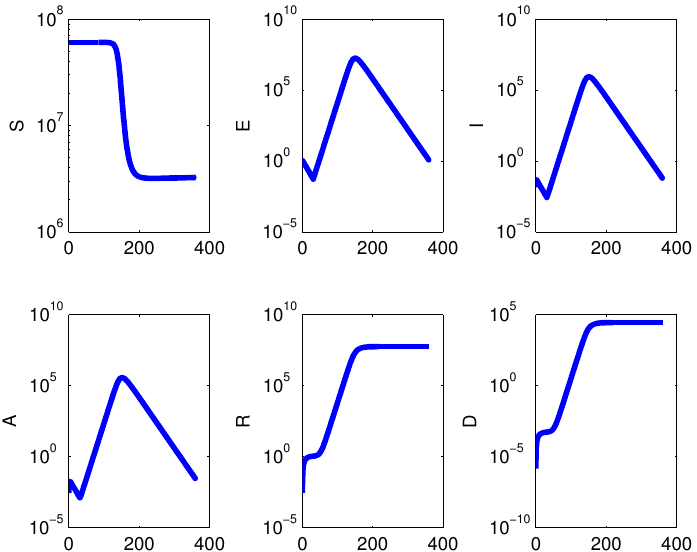
Figure 5. Using a semilogarithmic scale for the vertical axis, we show the results of absolute isolation, starting at time t 1 = 1 setting β I = 0 and lifting it at time t 2 = 30, returning to β I = 10 − 7 one month later, over a one year timespan for the model with demographics (1). Left to right and top to bottom, the subpopulations are: S , E , I , A , R and D , the disease-related deceased